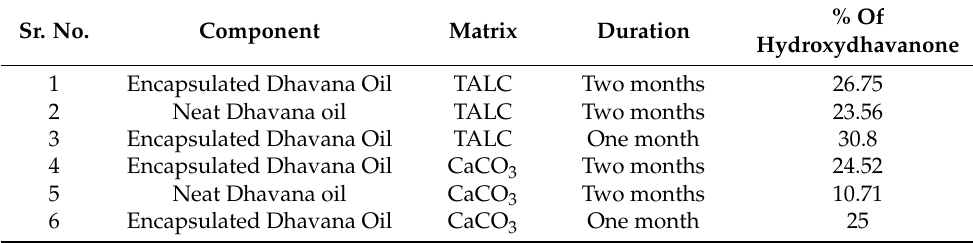
Table 7. Release of hydroxydhavanone from neat and encapsulated Dhavana oil. Sr. No.